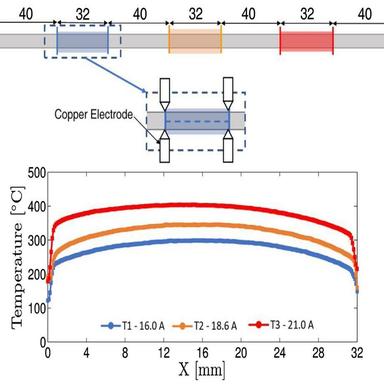
Temperature profile of each heat treated segment after the stationary condition is reached.